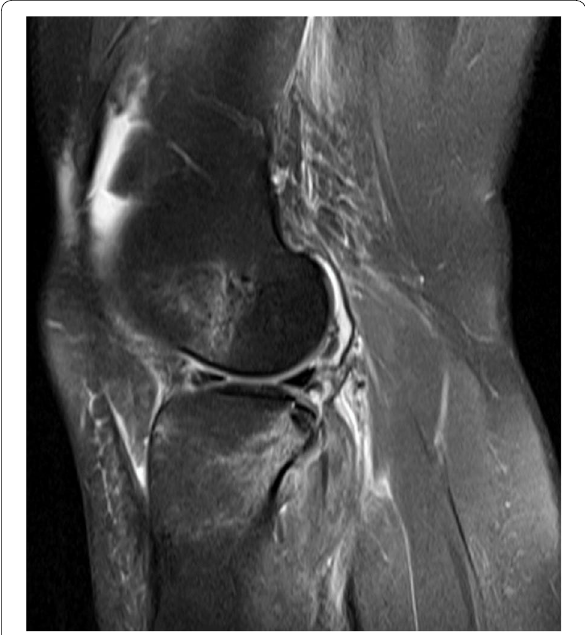
Fig. 1 MRI post-ACL rupture demonstrating severe bruising in the lateral femoral condyle and posterior tibial